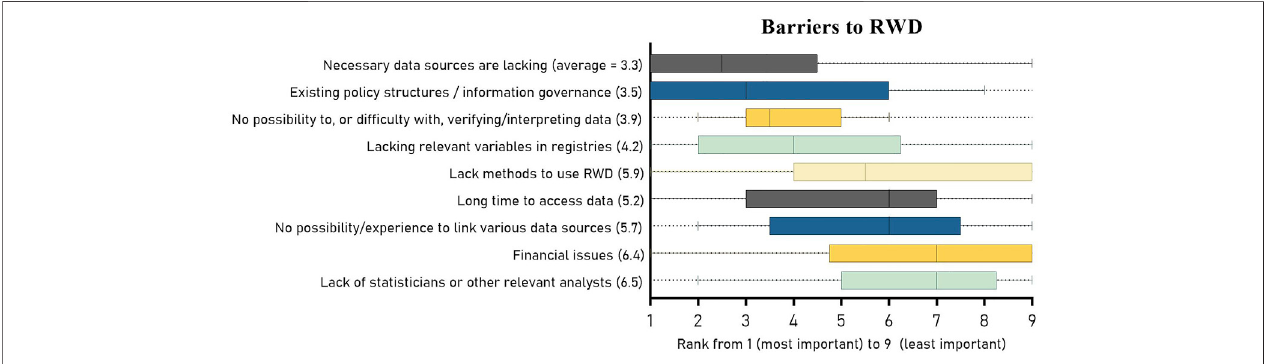
FIGURE3 | Boxplotsofthe ranking ofthe barriers toaccepting RWDin HTA or decision-making. Thebarriersare placed in order oftheir median rankedscoreand include the 25th and 75th percentile as well as the minimum and maximum rank. The mean scores are listed between brackets on the left side.